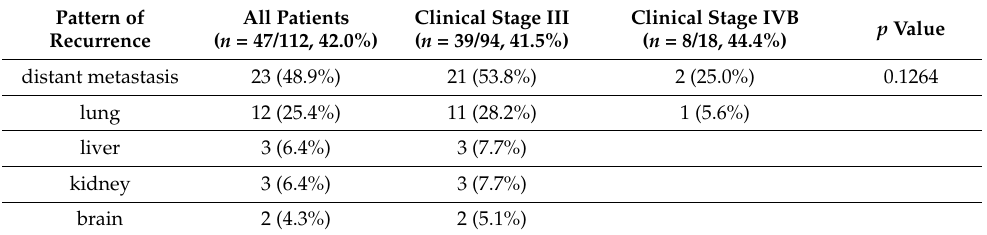
Figure 3. Kaplan–Meier analysis of pathologically supraclavicular LN metastasis-negative patients. The five-year OS was 56.8% and 23.8% among pathologically supraclavicular LN metastasis-negative and -positive patients, respectively ( A ). The five-year DSS was 66.6% and 23.8% among pathologically supraclavicular LN metastasis-negative and -positive patients, respectively ( B ).